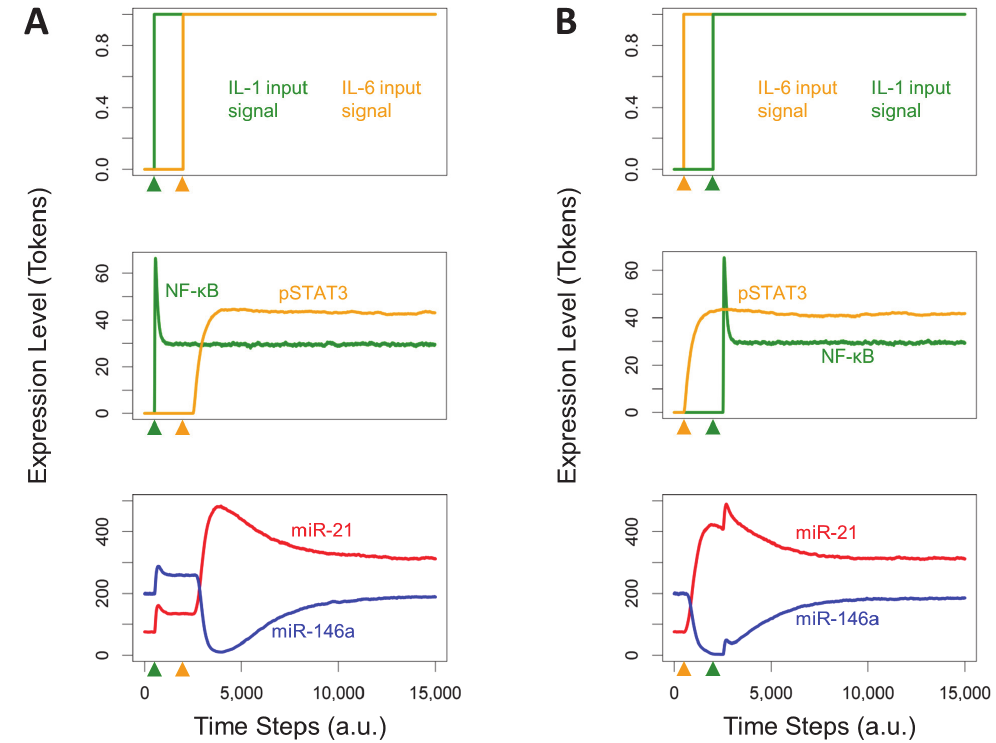
Figure 6. Dynamics of microRNA expression levels in response to differential timing of cytokine stimuli. ( A ) Expression levels with synchronized cytokine production; ( B ) Expression levels with staggered cytokine production (IL-6 produced before IL-1). Solid arrowheads denote the introduction of input cytokine